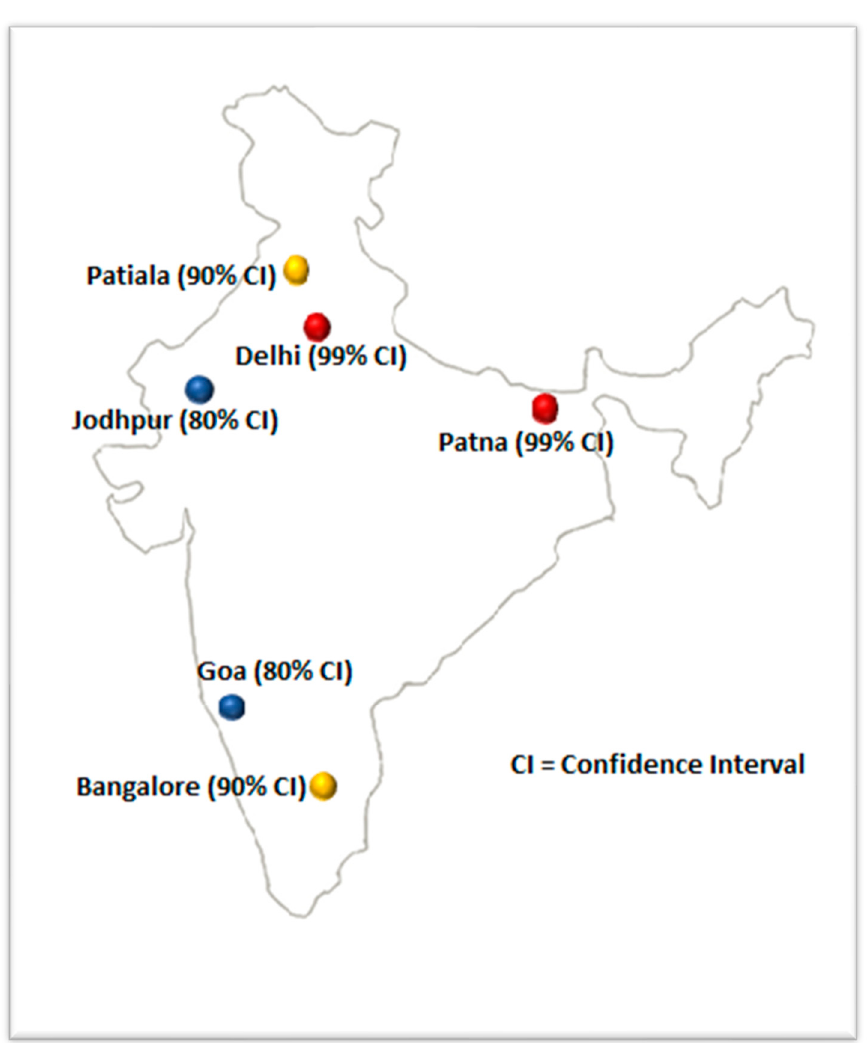
Figure 1. Considered locations and their corresponding confidence interval for the, Thunderstorm (TS), TS-Day prediction.